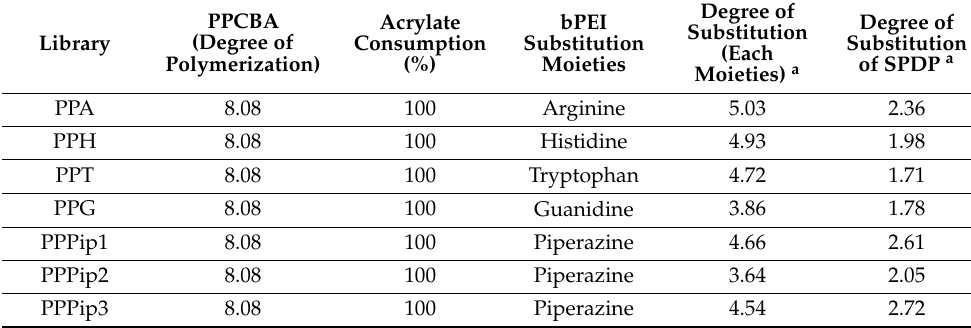
Table 1. Physicochemical characterization of PPA